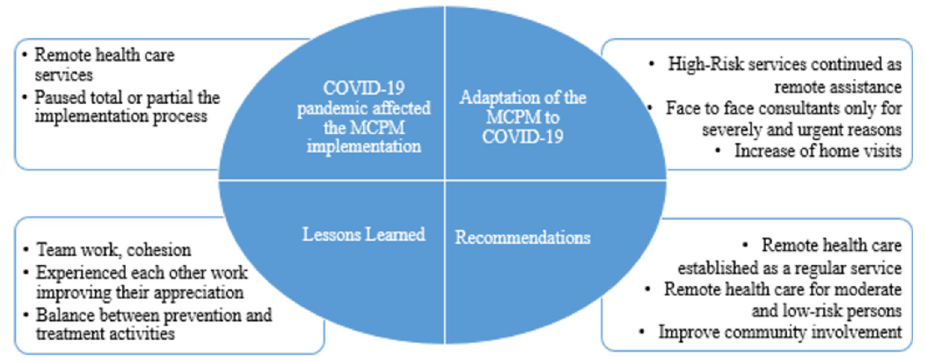
Fig 2. Summary of the main results of the